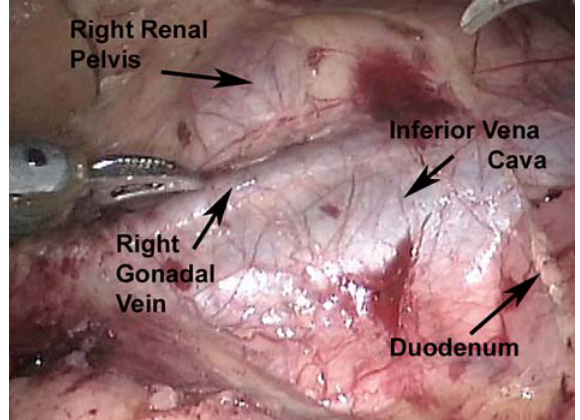
Figure 2 – Exposure.